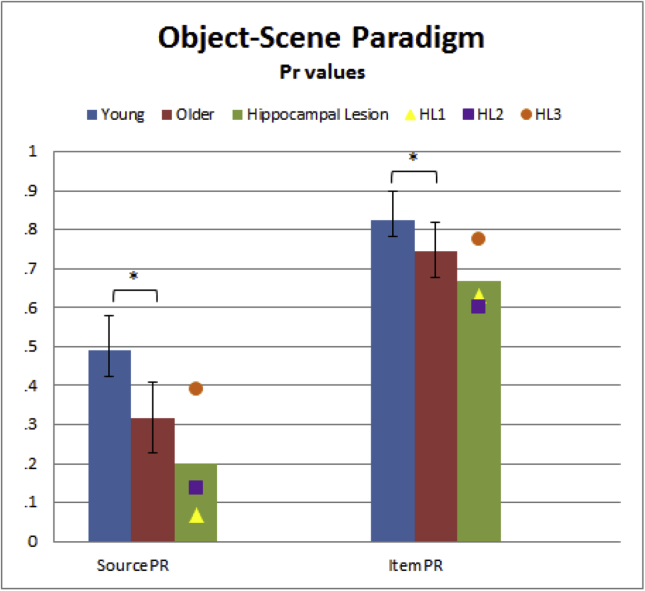
Source and Item memory Pr values from Object-Scene Paradigm for Young, Older, and Hippocampal Lesion (HL) groups. Group differences are marked: * = significant at p < .05 two-tailed; + = significant p < .05 one-tailed for a directional hypothesis. Error bars represent two-tailed 95% confidence intervals from a pooled error term (after inverse arcsine transformation), while individual scores are provided for the HL group.